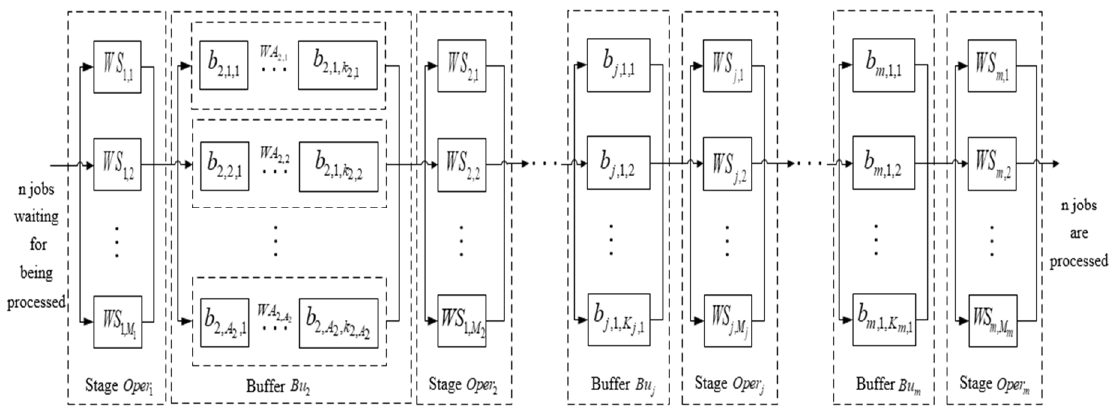
ff ers scheduling problems in a flexible flow Figure 1. Model for the multi-queue limited buffers scheduling problems in a flexible flow shop. Figure 1. Model for the multi-queue limited bu